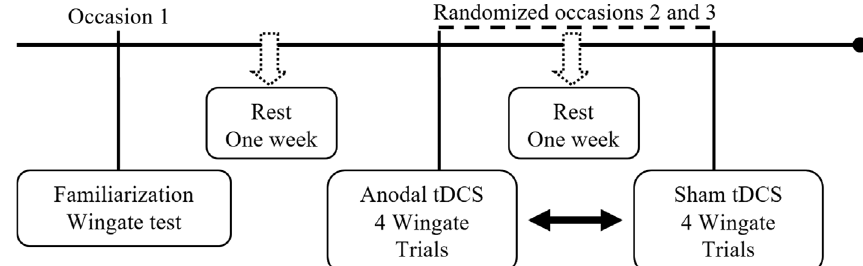
Figure 1 - Timeline of experimental